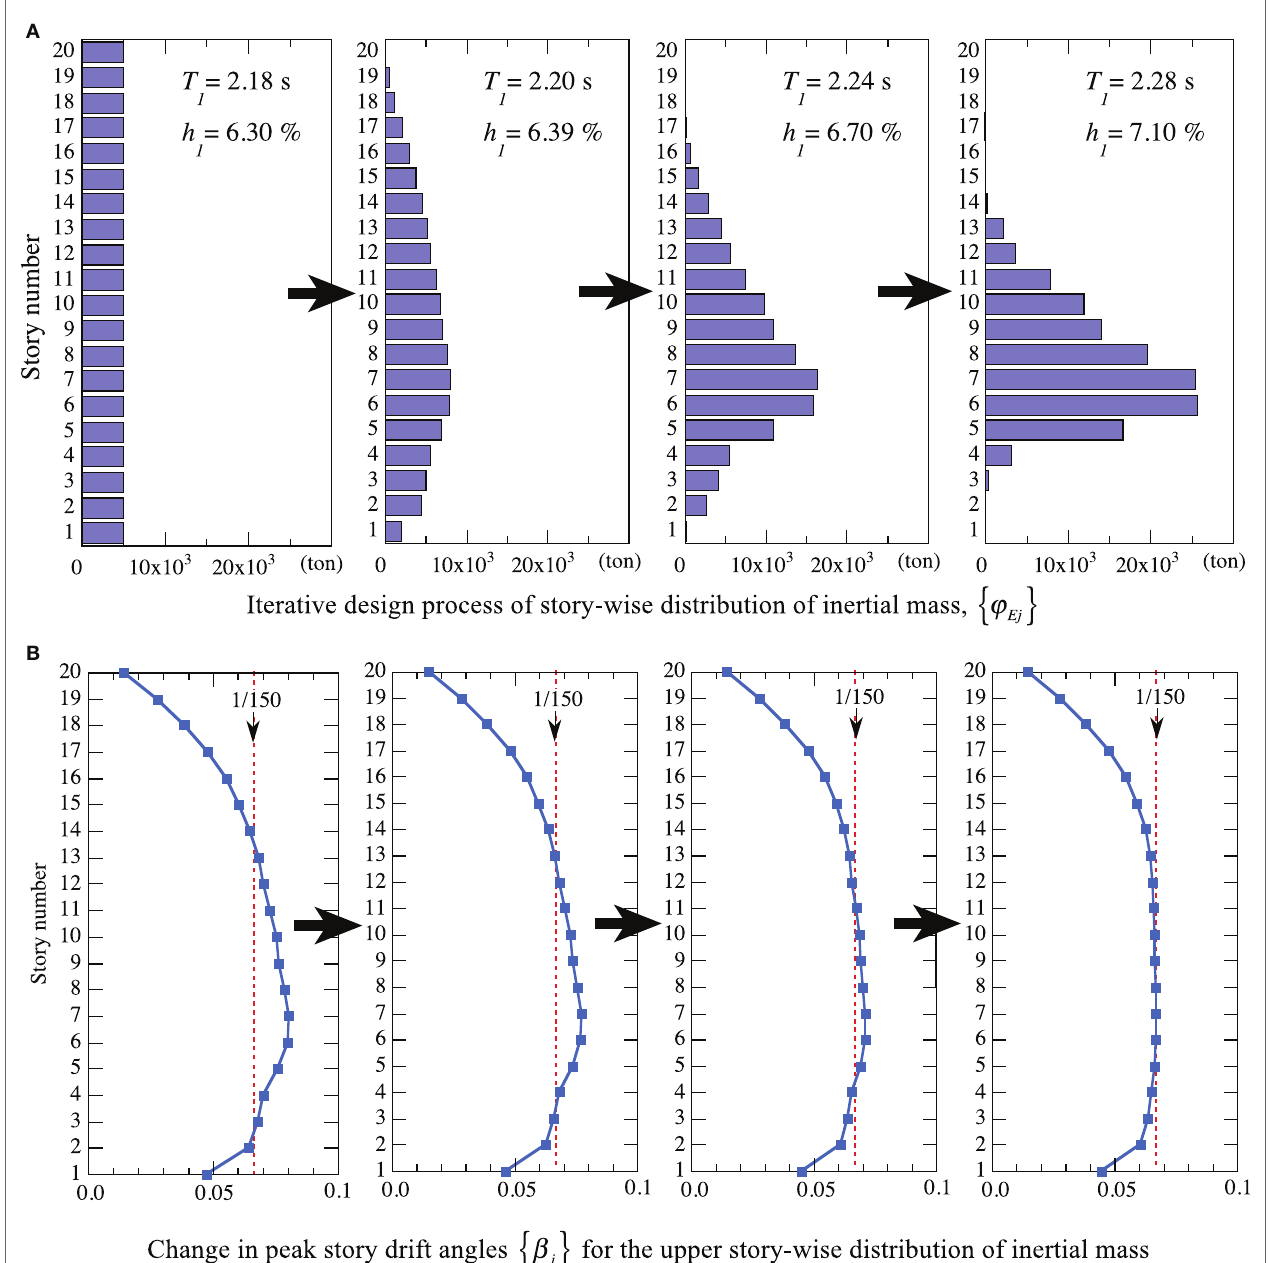
FIGURE 7 | Extracted progress of story-wise distribution of inertial mass and peak story drift angles in 20-story building for R = 2 Ω . (A) Iterative design process of story-wise distribution of inertial mass, { ϕ Ej }. (B) Change in peak story drift angles { β j } for the upper story-wise distribution of inertial mass.